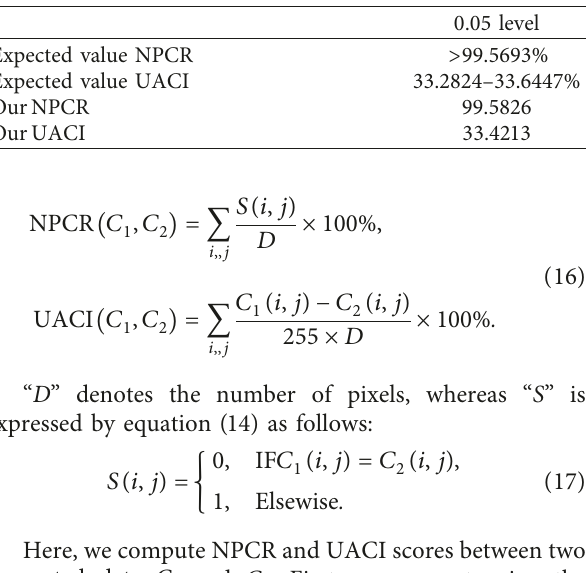
Table 6: Results of NPCR and UACI